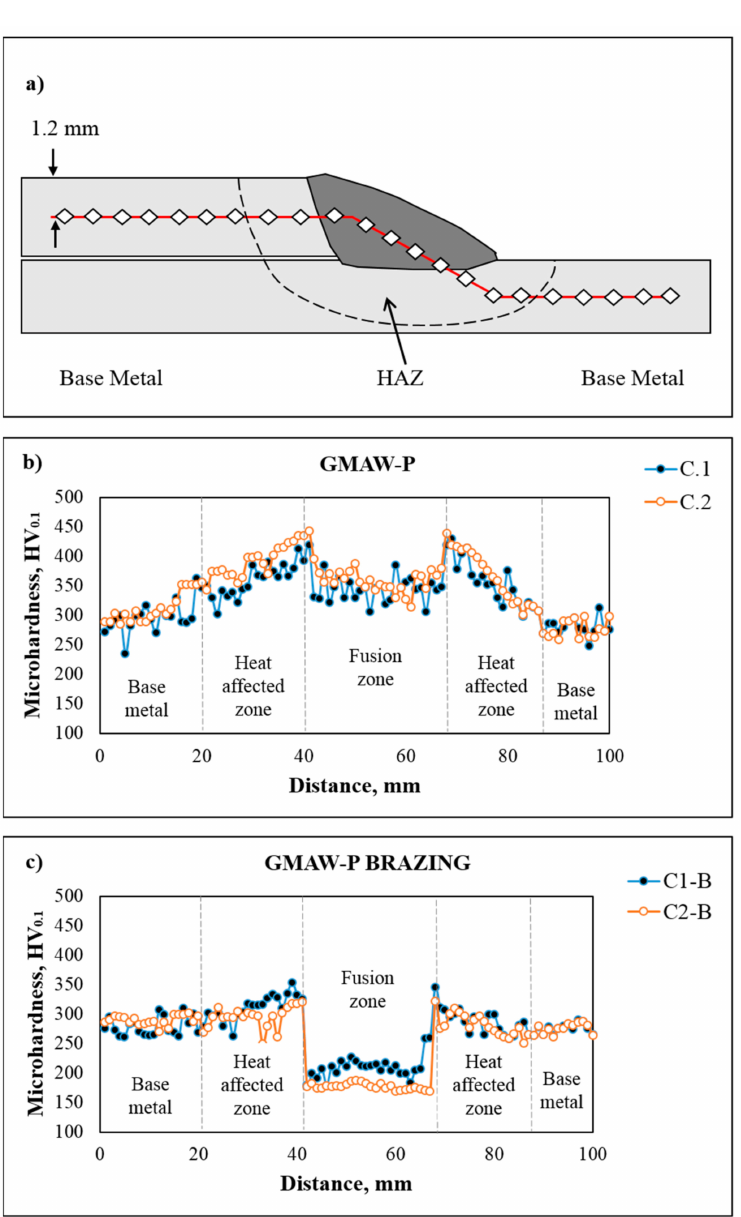
Figure 8. Microhardness profiles; ( a ) schematic of the measurements made in the lap welded joints,